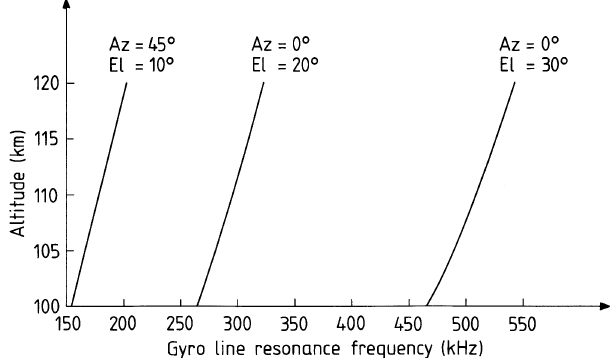
Fig. 2. Calculated gyro-line resonance frequencies between 100- and 120-km altitude for three different pointings of the antenna. Calcu- lations are based on the IGRF 1987 model for the geomagnetic field together with linear profiles for the electron density n (cid:101) and temper- ature „ (cid:101) ; n (cid:101) " 6 · 10 (cid:49)(cid:48) m (cid:126)(cid:51) , „ (cid:101) " 200 K at 100 km; n (cid:101) " 10 (cid:49)(cid:49) m (cid:126)(cid:51) ,